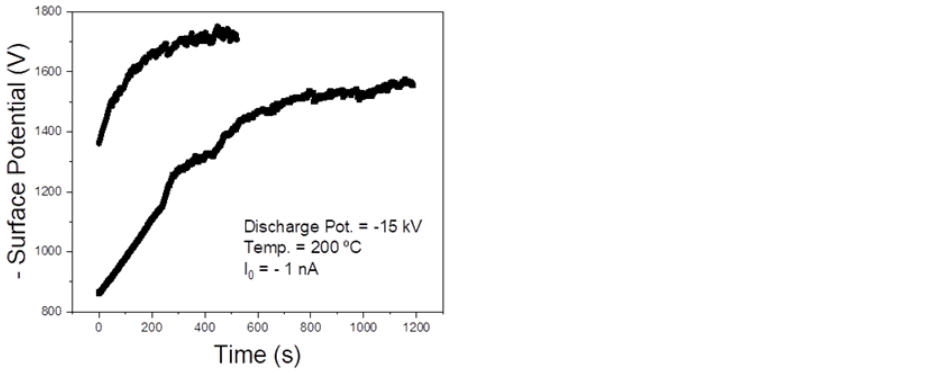
Figure 4. Example of two surface potential buildup curves for two APS Hap coatings negatively charged with a constant current of −1 nA.